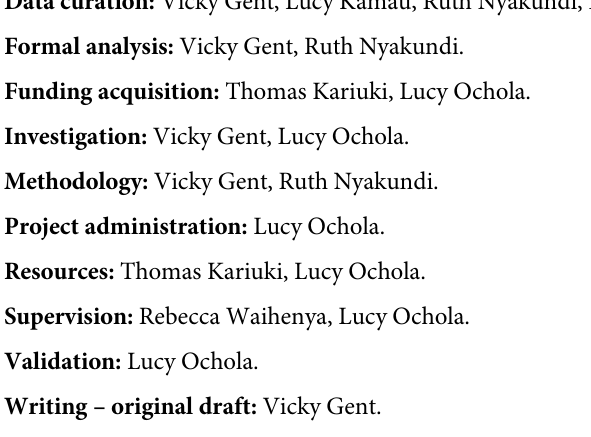
S4 Table. IgG ELISA data. S5 Table. Median Fluorescence Intensity (MFI) and Robust SD (rSD) for proliferating cells. S6 Table. IL-4 concentration data. S7 Table. IFN- γ concentration